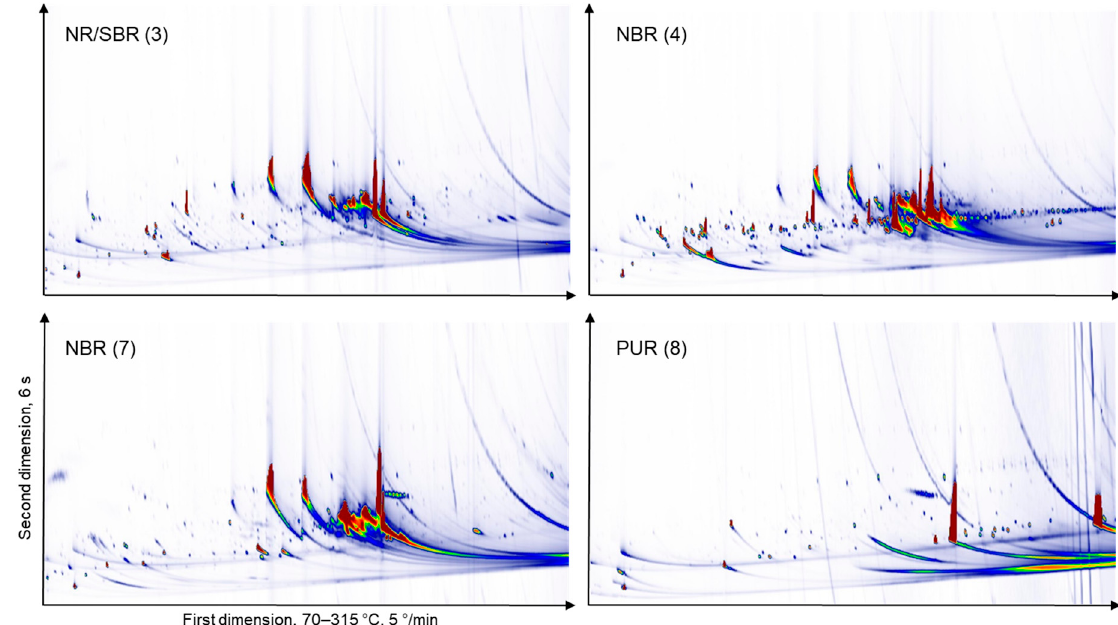
Figure 5. GC × GC-FID chromatograms of a selection of migration solutions in 50% ethanol by on-column injection. The chosen samples correspond to those in Figure 4.